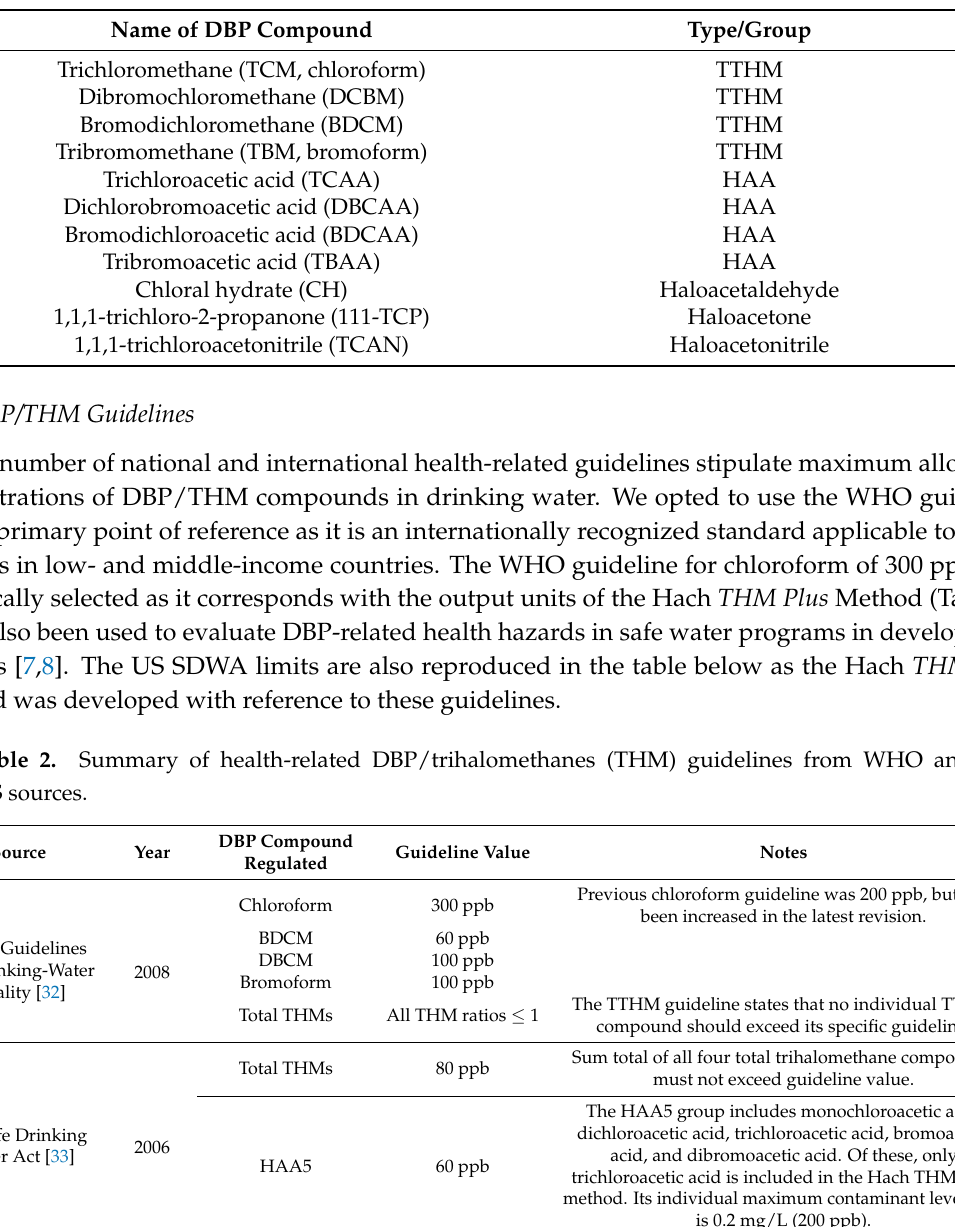
Table 1. Eleven disinfection by-products (DBPs) measured by the Hach THM Plus Method.